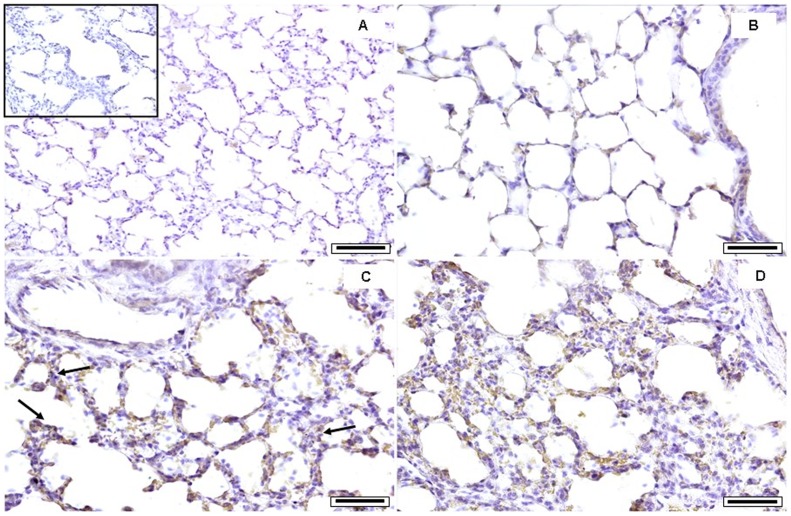
Lung immunohistochemical analysis.Immunohistochemical analyses of HO-1 expression in lung tissue 24 h after the third intratracheal instillation; the brown color reflects the site and intensity of HO-1 expression. (A): lung of sham mice; in the box, a control of the immunohistochemical reaction specificity, where the primary antibody has been avoided, in a PM10sum instilled mouse; (B): alveolar and peribronchiolar spaces in the lung of a sham mouse; (C, D): alveolar and peribronchiolar spaces in lungs of PM10sum-treated mice. Each figure represents the status evidenced examining 6 sham and 6 PM10sum-treated mice. A bar = 150 µm; B–D bars = 50 µm.